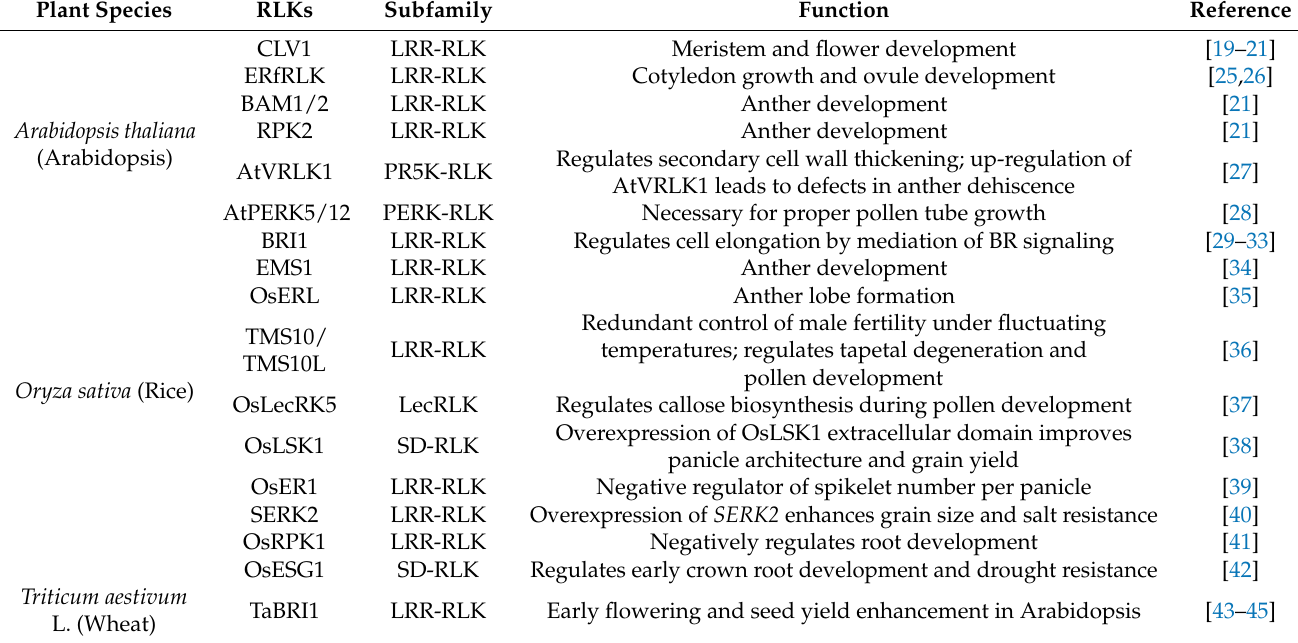
Table 2. RLKs regulate plant growth and